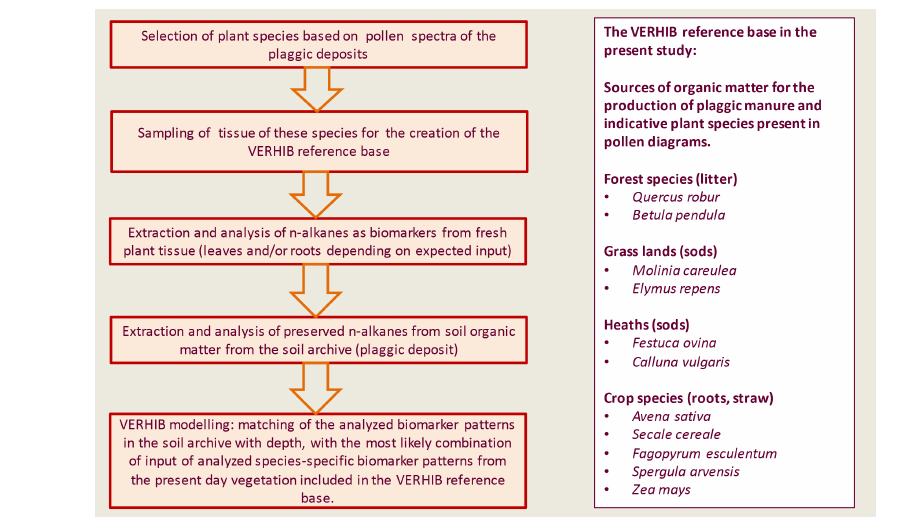
Figure 6. Flow diagram of the methodology of biomarker analysis.